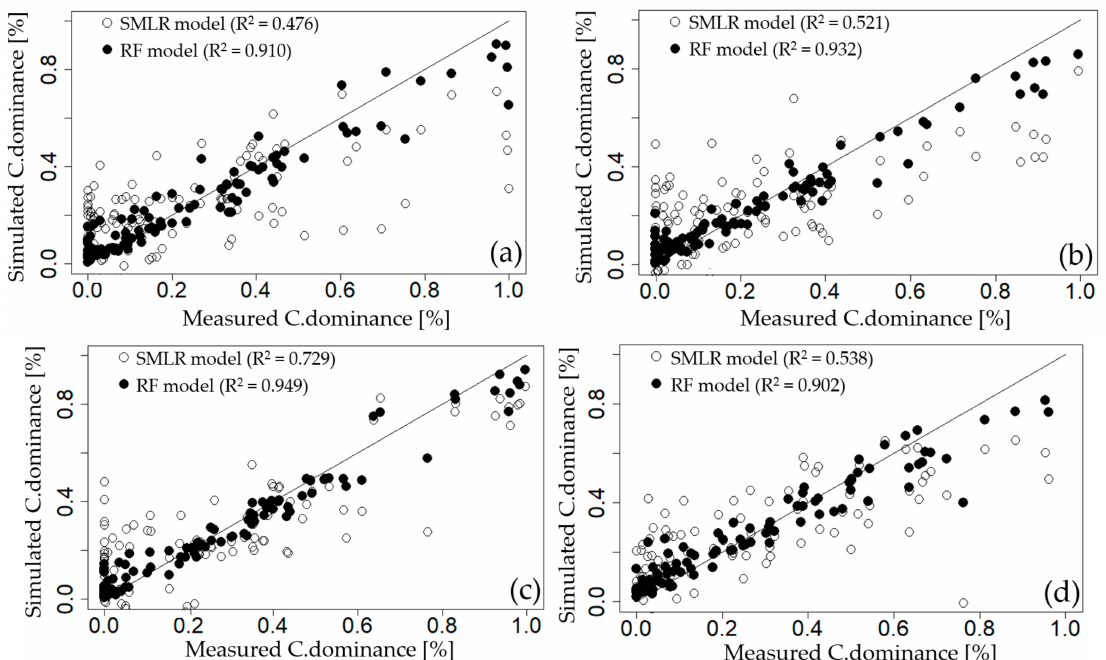
Figure 5. Comparison of measured cyanobacterial dominance with simulated results using step-wise multiple linear regression (SMLR) and random forest (RF) models at; (a) Gangjeong Goryeong weir (GGW), (b) Dalseong weir (DSW), (c) Hapcheon Changnyeong weir (HCW), and (d) Changnyeong Haman weir